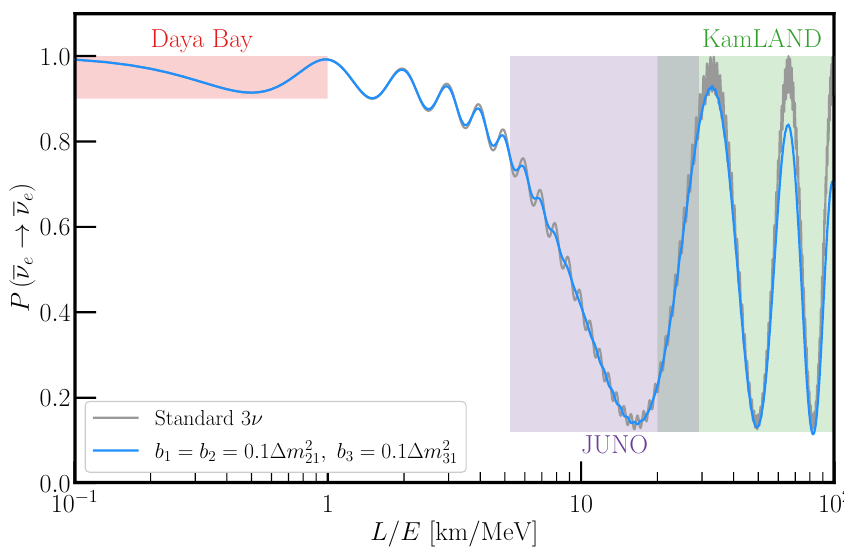
Figure 8. Oscillation probability for reactor antineutrinos as a function of L/E for the standard three-neutrino case (grey) and including nonzero spectral-function breadths as indicated in the legend (blue). We shade the regions of L/E probed by existing/future experiments Daya Bay (red), JUNO (purple), and KamLAND